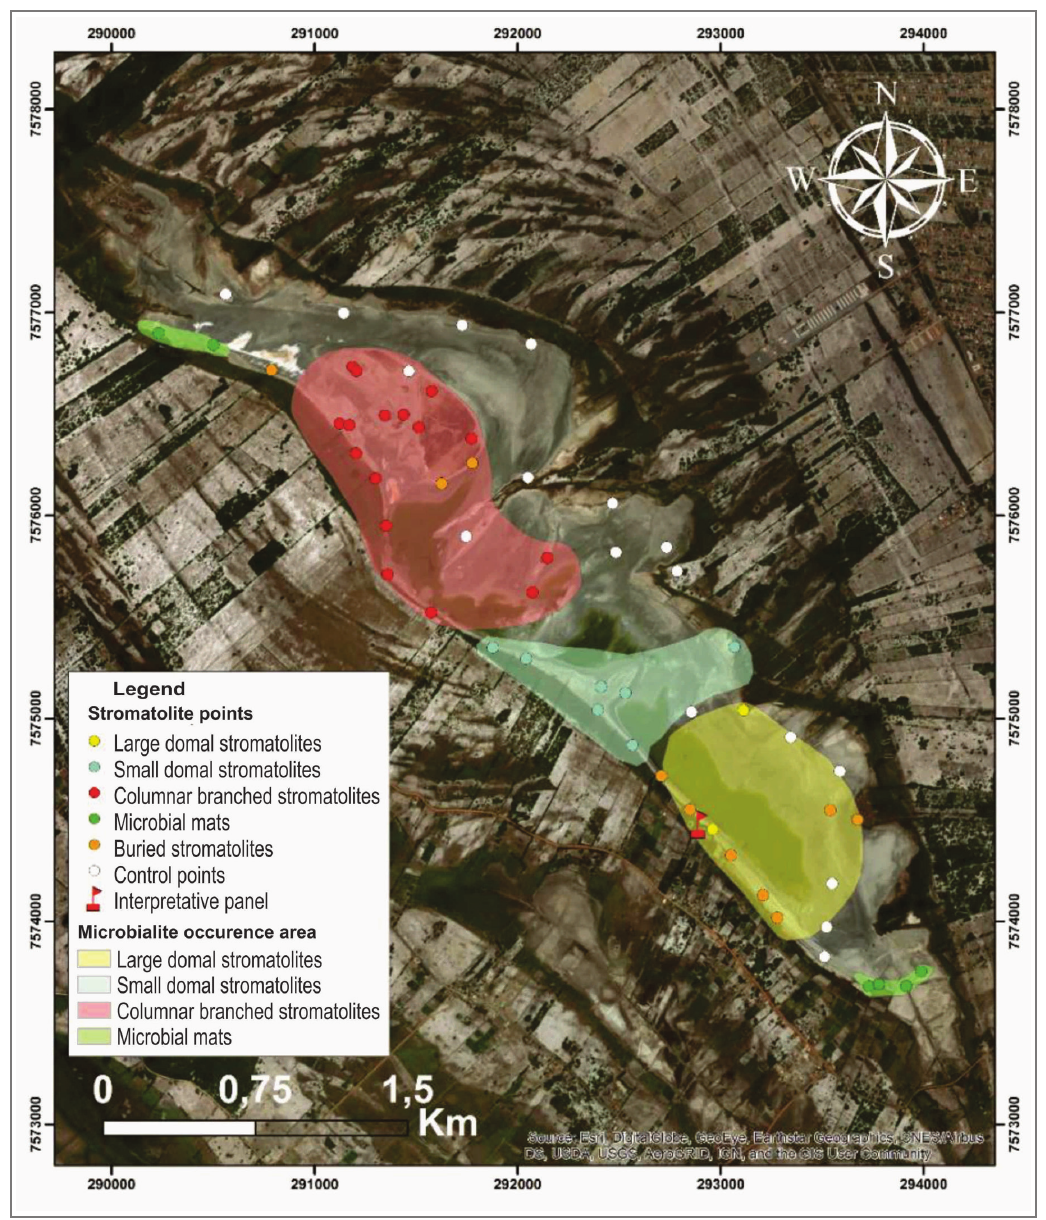
Figure 10 - Map of the location of the microbialites of Lagoa Salgada, separated by microbial mats, types of stromatolite and their regions of occurrence (Adapted from Silva